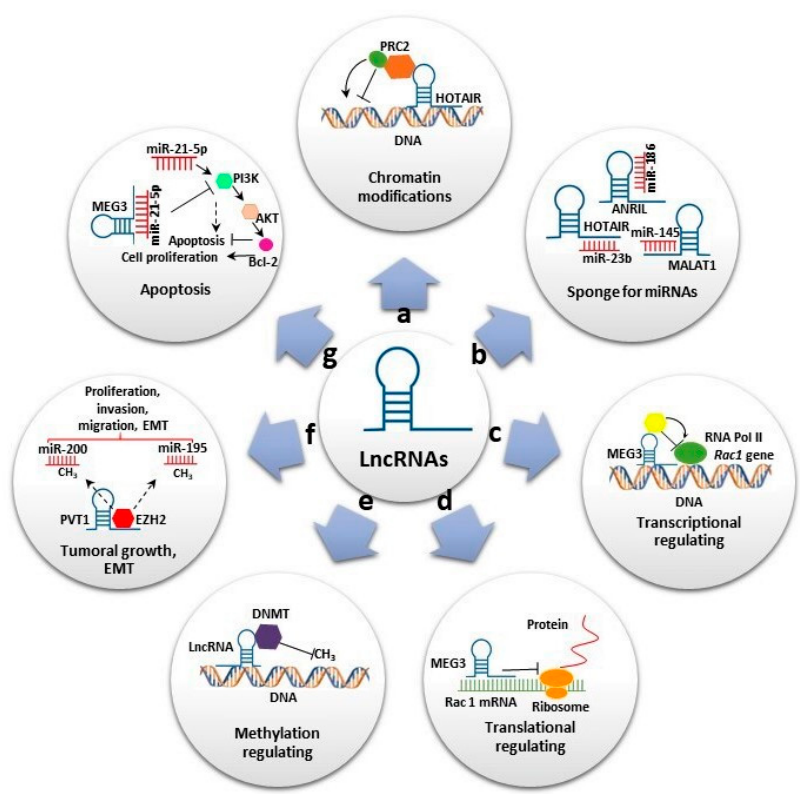
Figure 1. Long noncoding RNAs’ (lncRNAs) biological roles. ( a ) Some lncRNAs regulate gene expression by assembling chromatin-modifying complexes. Homeobox transcript antisense RNA (HOTAIR) interacts with polycomb repressive complex 2 (PRC2) and establishes the repressive H3K27me3 chromatin mark. ( b ) lncRNAs can act as miRNA sponges. HOTAIR, Metastasis-associated lung adenocarcinoma transcript 1 (MALAT1) and Antisense noncoding RNA in the inhibitors of cyclin-dependent kinase 4 (ANRIL) sponge miR-23-b, miR-154 and miR-186, respectively, to reverse suppression of their target genes. ( c , d ) Some lncRNAs promote or suppress gene expression. Maternally expressed gene 3 (MEG3) inhibits Rac1 at both transcriptional and translational levels. ( e ) Some lncRNAs interact with diverse DNMT members, promoting or repressing DNA methylation. ( f ) Some lncRNAs play important roles in cell migration, proliferation and invasion. Plasmacytoma variant translocation 1 (PVT1) binds to EZH2, increasing H3K27me3 level on miR-195 and miR-200b promoters and promoting epithelial–mesenchymal transition (EMT). ( g ) lncRNAs also play significant roles in apoptosis. MEG3 reduce the level of miR-21-5p expression, inhibiting cell proliferation and increasing apoptosis by regulating the PI3K / AKT / BCL-2 / Bax / P21